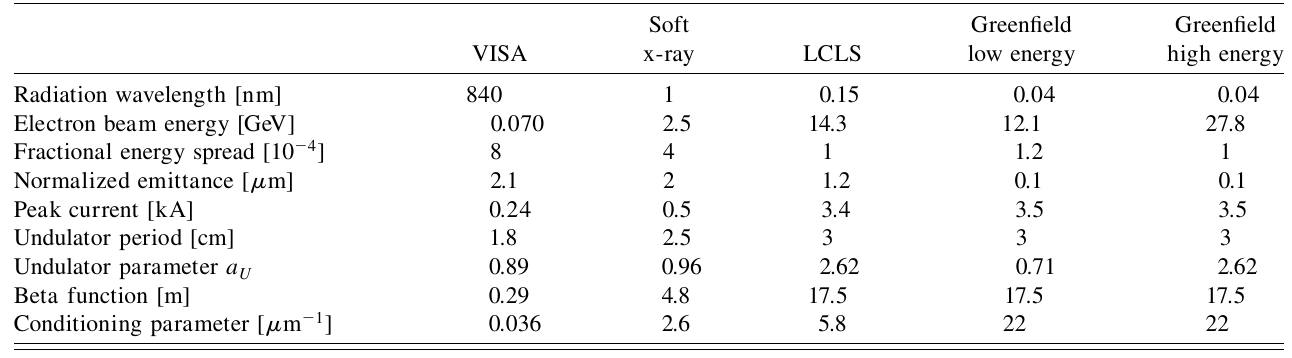
TABLE I. Parameters used in modeling four